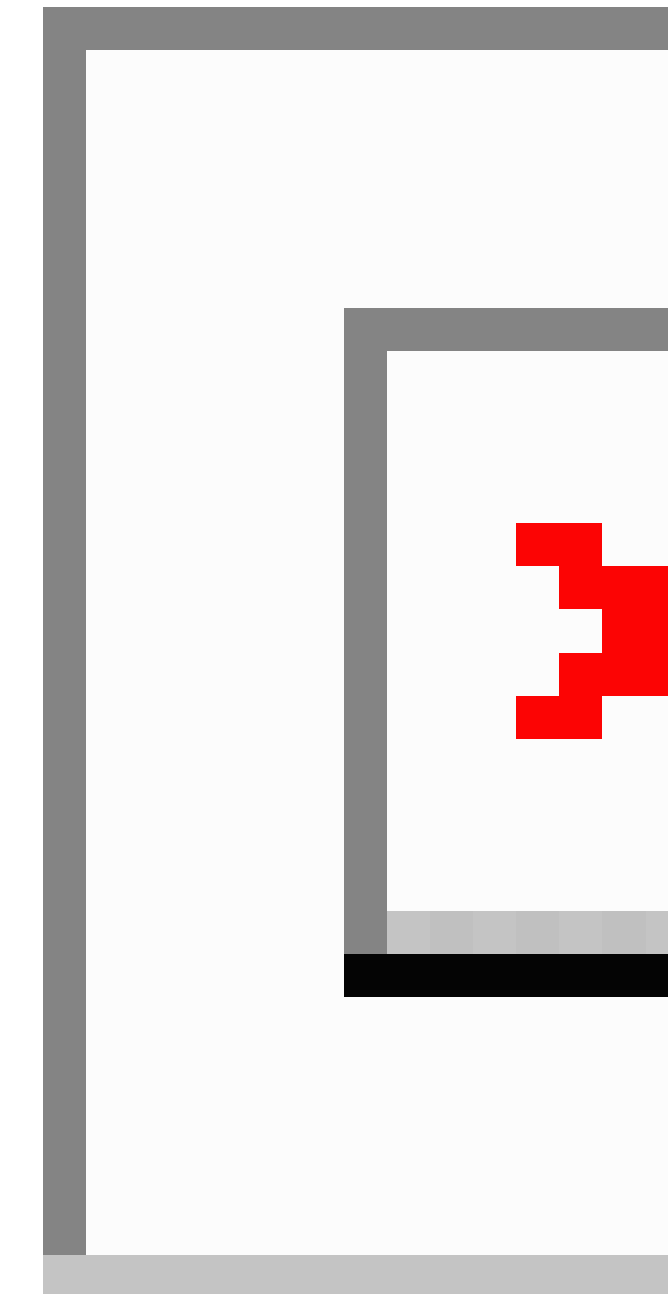
Figure 6. Generalized additive regression plots of information